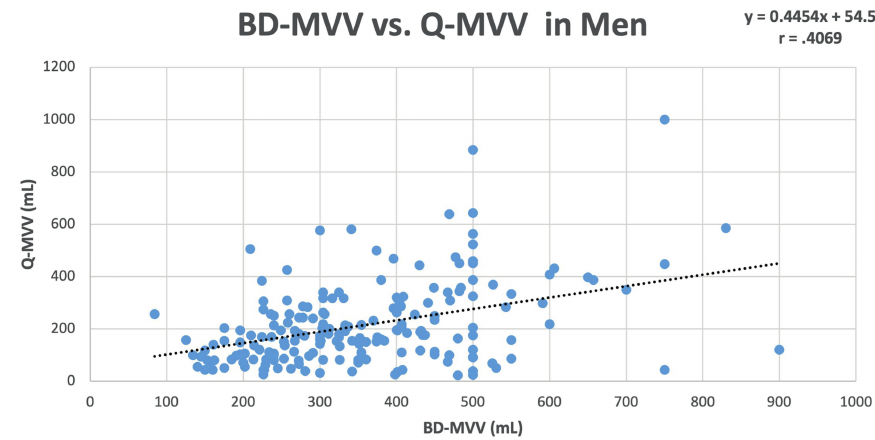
Figure 3 - Scatterplot of bladder diary BD-MVV vs. Q-MVV in men